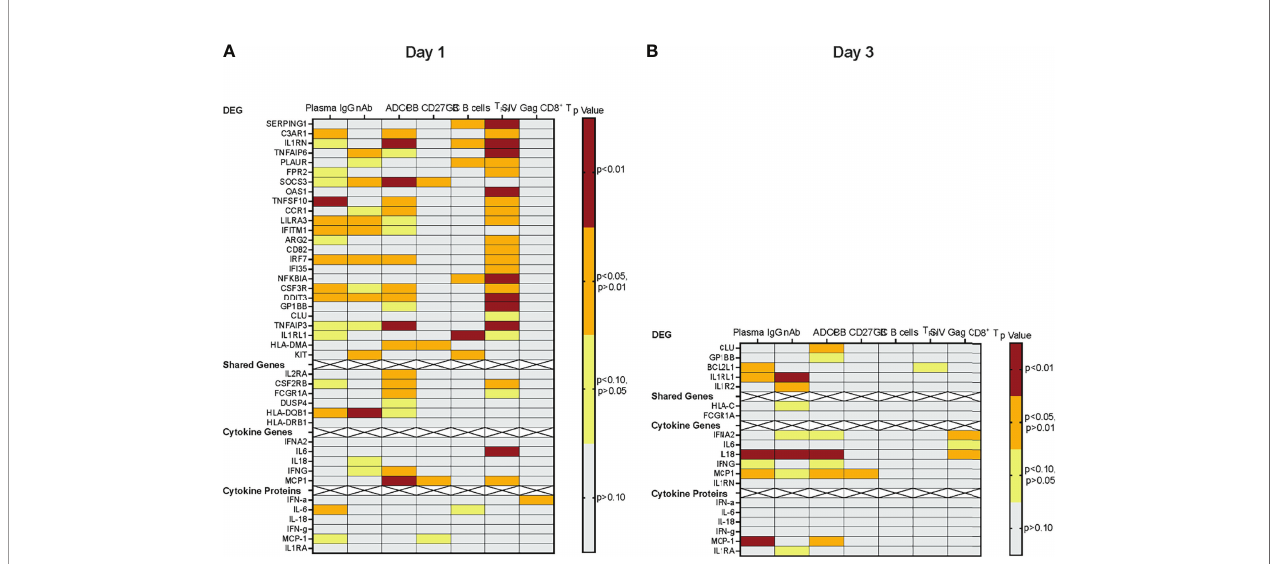
FIGURE 9 | Correlations of early vaccine prime-induced and vaccine-induced adaptive immune responses. Correlations for D1 or D3 are illustrated in Panels (A) or (B) , respectively. The left y-axis lists the various genes or proteins included in the correlation analyses: (i) DEG, (ii) shared pathway genes, (iii) genes of elevated plasma cytokines, or (iv) plasma cytokines. The strength of the correlation between gene expression and a speci fi c immune parameter is indicated by a heatmap using the relevant Spearman rank correlation unadjusted p values (see color legend). Each column represents a speci fi c immune response, including - from left to right – Env-speci fi c plasma IgG, tier 1 MW965-speci fi c neutralizing antibody ID 50 titers, ADCC endpoint titers, peripheral blood memory B cells at week 34, germinal center B cells in axillary lymph nodes at week 34, Env-speci fi c follicular T helper cells in axillary lymph nodes at week 34, and SIV Gag-speci fi c peripheral blood CD8 + T cell responses at week